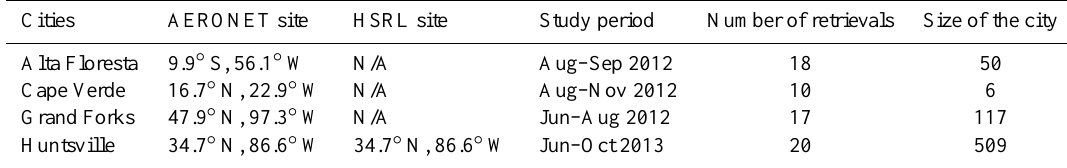
Table 1. Basic information for each of the test sites, including site name, AERONET and HSRL site latitude–longitude locations, and date range of the respective study periods. The “Size of the city” column indicates the number of pixels used in the calculations. Cities AERONET site HSRL site Study